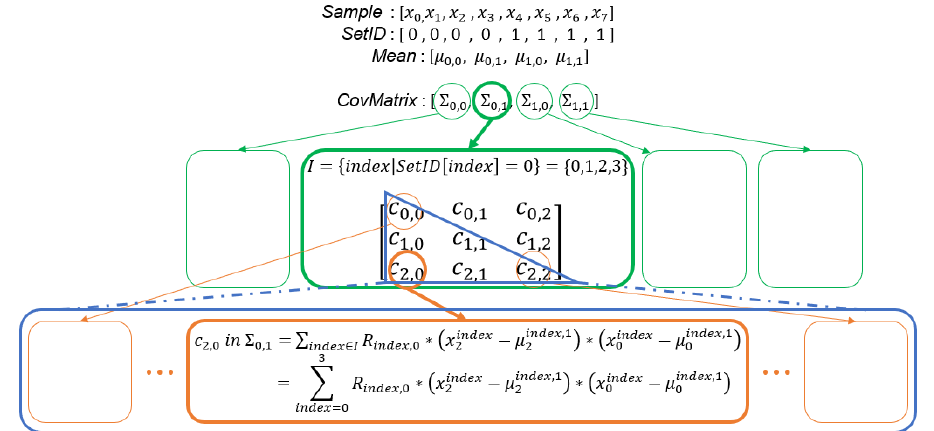
Figure 15. In this example, two 3-variate GMMs are modeled at the same time, and each GMM has two Gaussian components. The level of parallelism is 2 ∗ 2 ∗ 3 ∗ ( 1 + 3 ) /2 = 24 when the optimization introduced in this section is